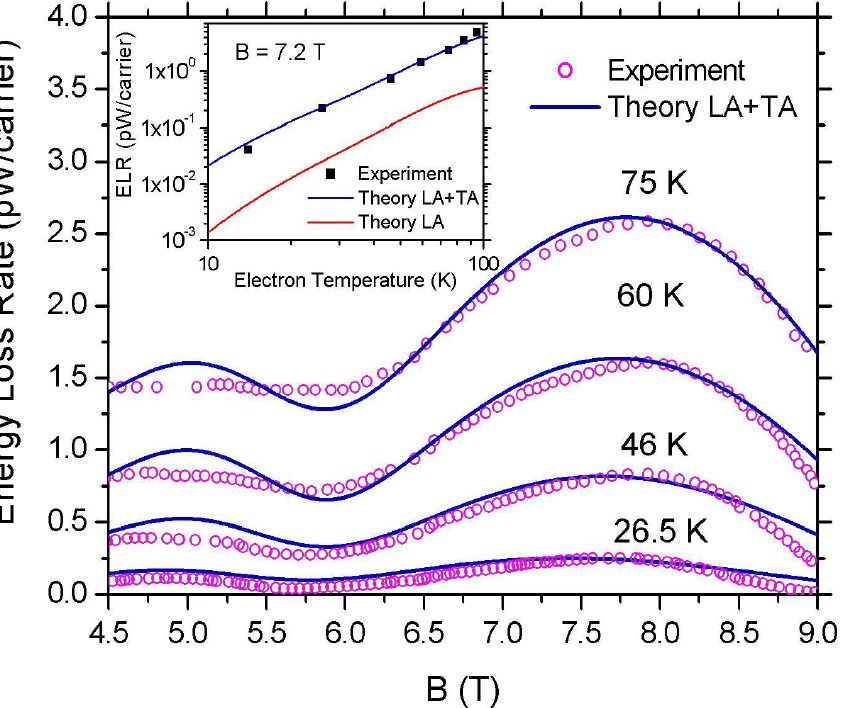
Figure 8. Comparison between theoretical and experimental values [21] of ELR in graphene around ν = 6 and ν = 10 at electron temperatures in the range 10–100 K. The carrier density is n s = 13.9 × 10 15 m − 2 . The solid blue lines and the open circles represent, respectively, the theoreti- cal calculations and the experimental data of F ( B ) obtained as it is explained in the text. In the inset, the filled squares are the experimental data [21] of ELR as a function of T e at ν = 6. The solid blue line is the theoretical estimation of F ( T e ) when both LA and TA acoustic modes are considered. For comparison, we show also the contribution from the LA branch when only screened deformation potential coupling is taken into account (red solid